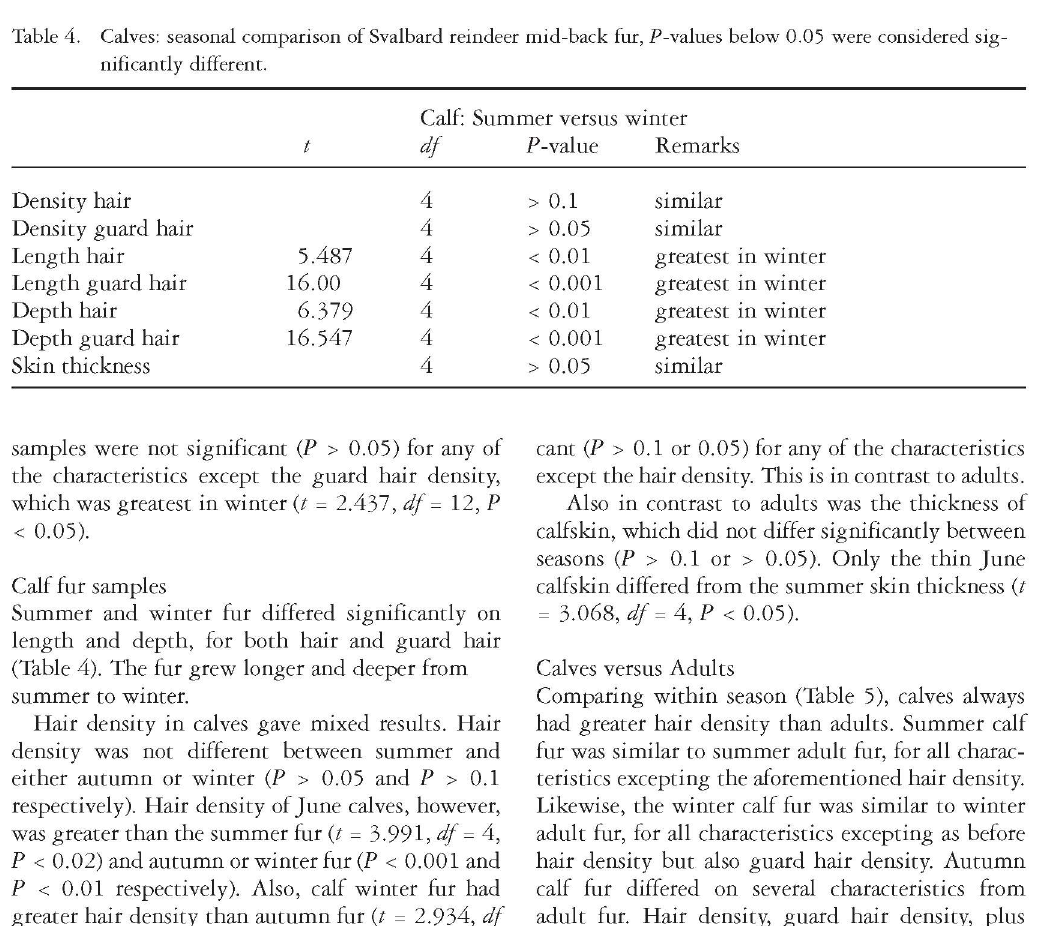
Table 5. Comparison of calf and adult samples of Svalbard reindeer mid-back fur, P -values below 0.05 were consid¬ ered significantly